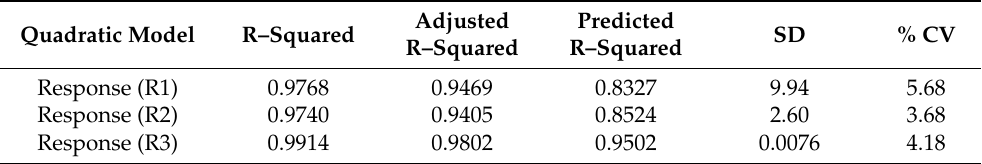
Figure 2. Three-dimensional (3D) surface response plot ( A – F ) indicating comparative effects of polymer, surfactant, and sonication time on responses, particle size ( A – C ), % drug release ( D – F ), and PDI ( G – I ). Table 3. Summary results of regression analysis for response fitting of quadratic models for R1, R2, and